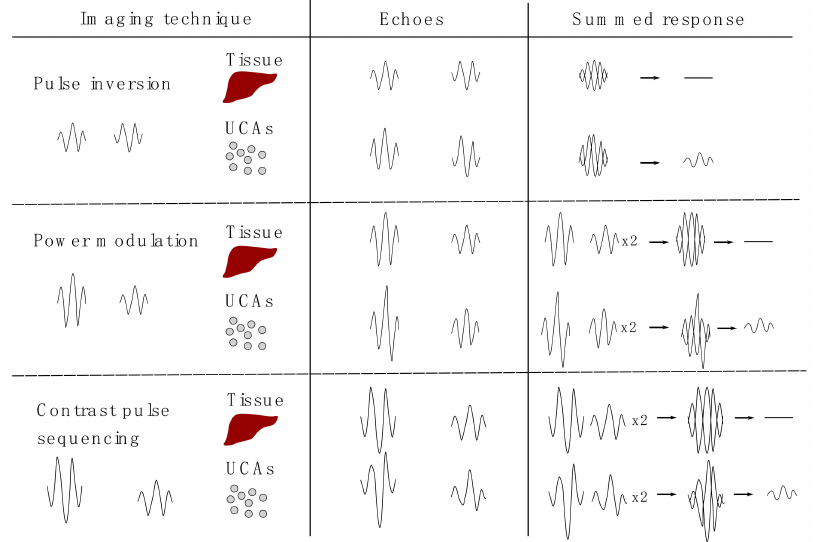
Figure 2. Theoretical background of imaging techniques based on the non-linear response of UCA. During pulse inversion two pulses are transmitted. The second pulse is shifted by 180